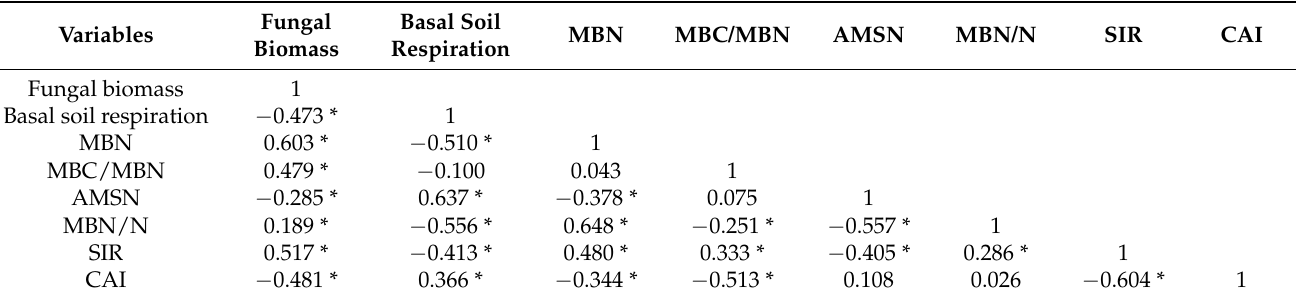
Table 7. Correlation between the soil biological